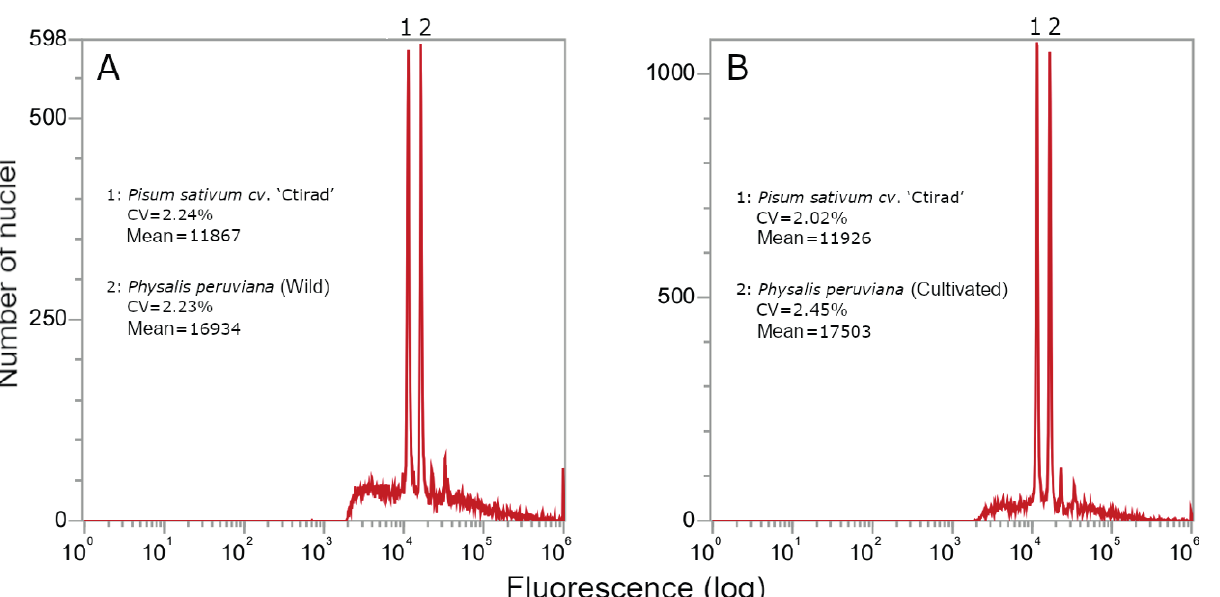
rDNA-bearing chromosome